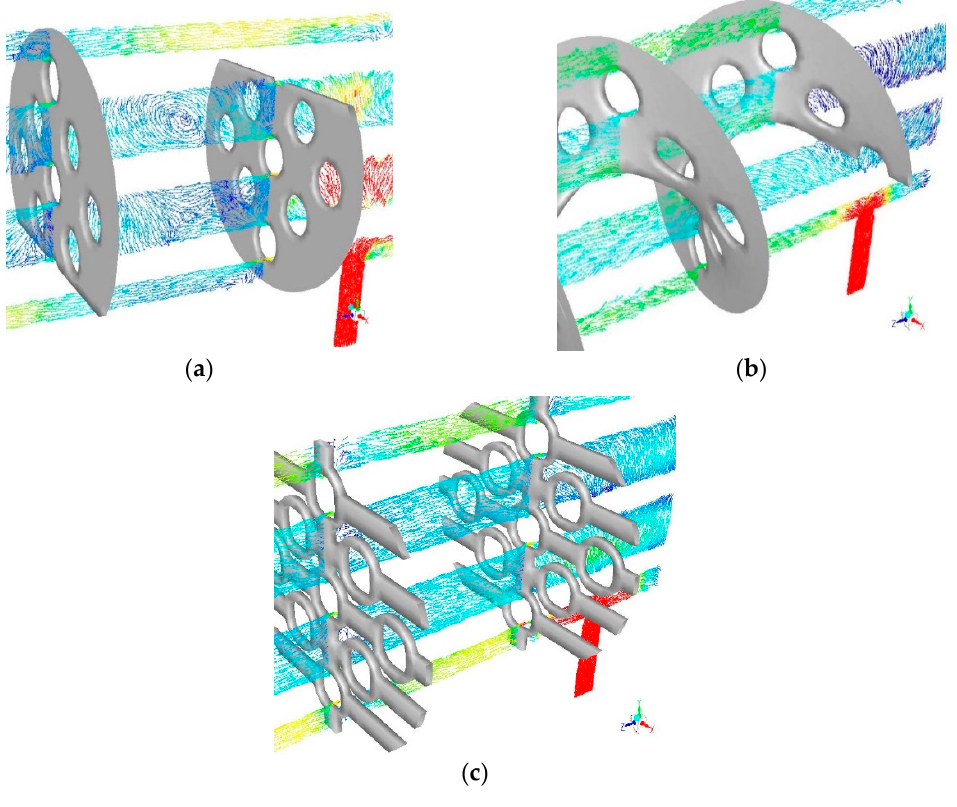
Figure 7. Velocity vectors: ( a ) segmental baffles; ( b ) helical baffles; and ( c ) clamping antivibration baffles.